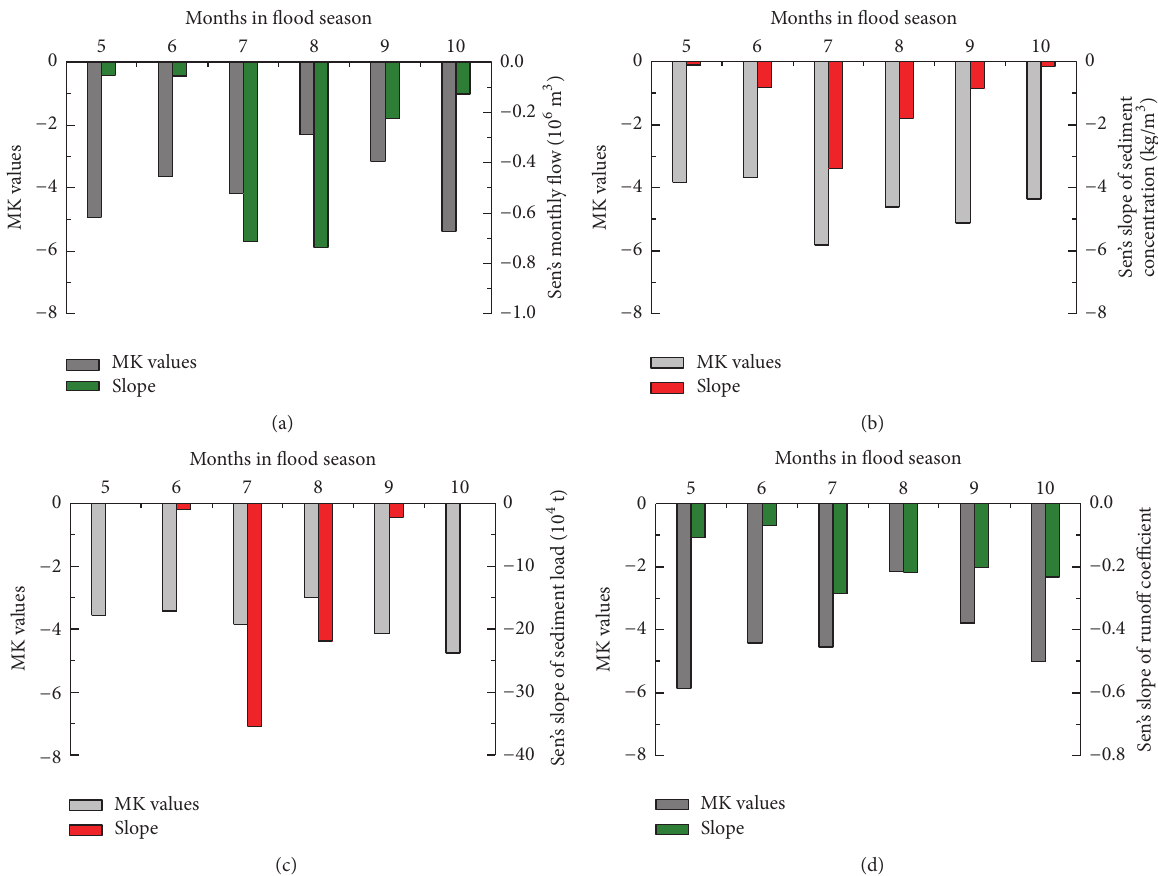
Figure 4: MK test of runoff and sediment indices in flood season at Huangfu station (MK test for monthly runoff (a), sediment concentration (b), sediment load (c), and runoff coefficient (d)).